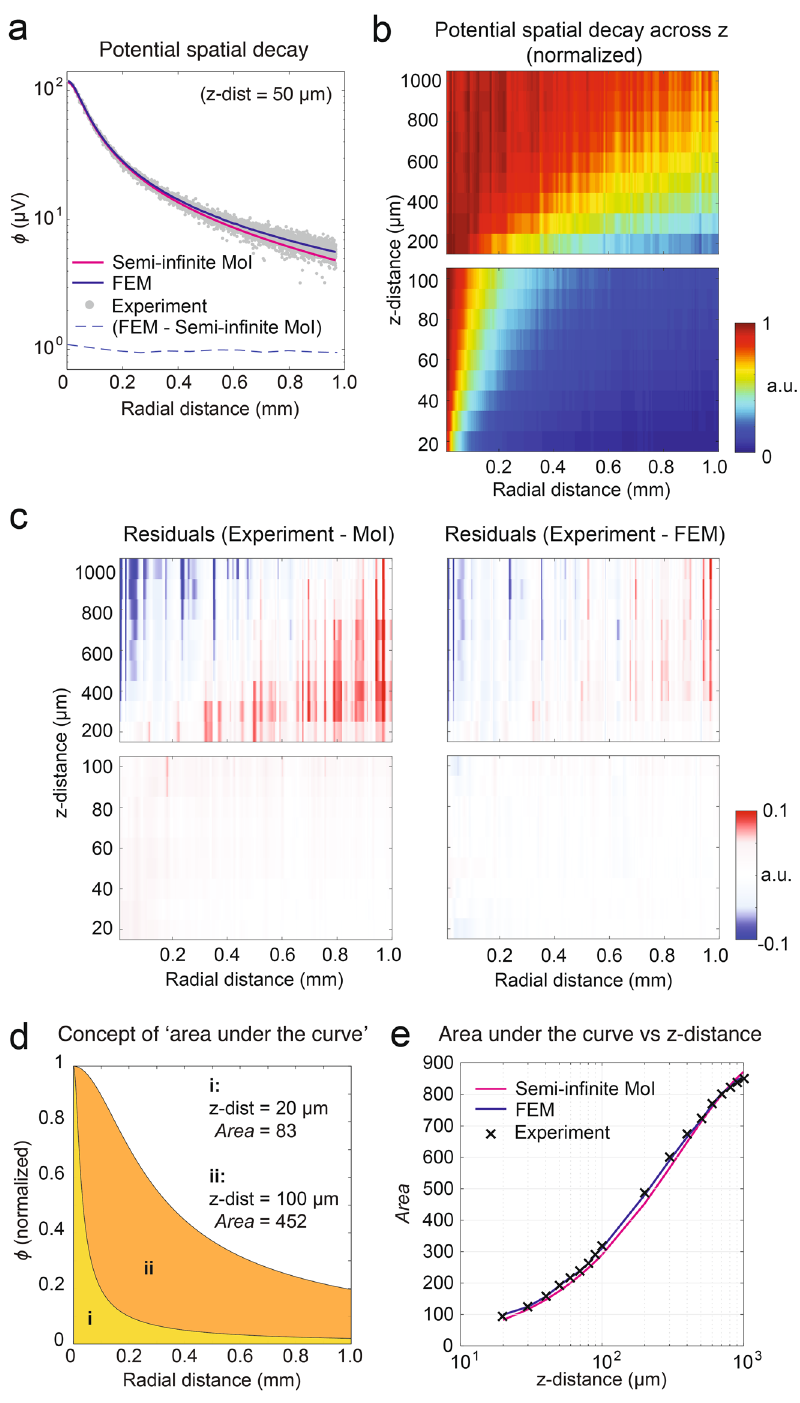
Figure 3. The z-distance between the micropipette and the HD-MEA can be estimated according to the electrical potential spatial distribution. ( a ) Exemplary potential spatial decay for a z-distance of the point source of 50 μ m including experimental data (gray dots), and data derived from a method-of-images or MoI model (pink line) and a finite-element or FEM model (blue line). The differences between the FEM and MoI values are displayed as a blue dashed line. The gray dots represent potential values measured through the 11’000 electrodes shown in Fig. 1c. ( b ) Experimentally determined potential spatial distributions, normalized to the maximum potential value per z-distance. ( c ) Residuals computed by subtracting the normalized potential spatial decays of experiments and models: MoI (left) and FEM (right). In general, the FEM model residuals are closer to zero. ( d , e ) Comparison of potential spatial decays according to the area under the curve ( Area ), computed by numerical integration over the interval of 1 to 1000 μ m distance from the peak value. The Area provides information on the steepness of the curve: the slope is infinite if the Area is zero and the slope is zero if the Area is 1000. ( d ) Two MoI-based potential spatial decays (normalized) for z-distances of 20 μ m (i) and 100 μ m